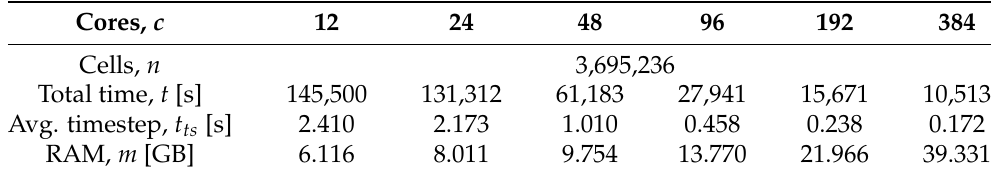
Table A2. Scalability and performance on the fine grid for original setup. Assessment is made for the k − ω TNT model. Presented values are three-run